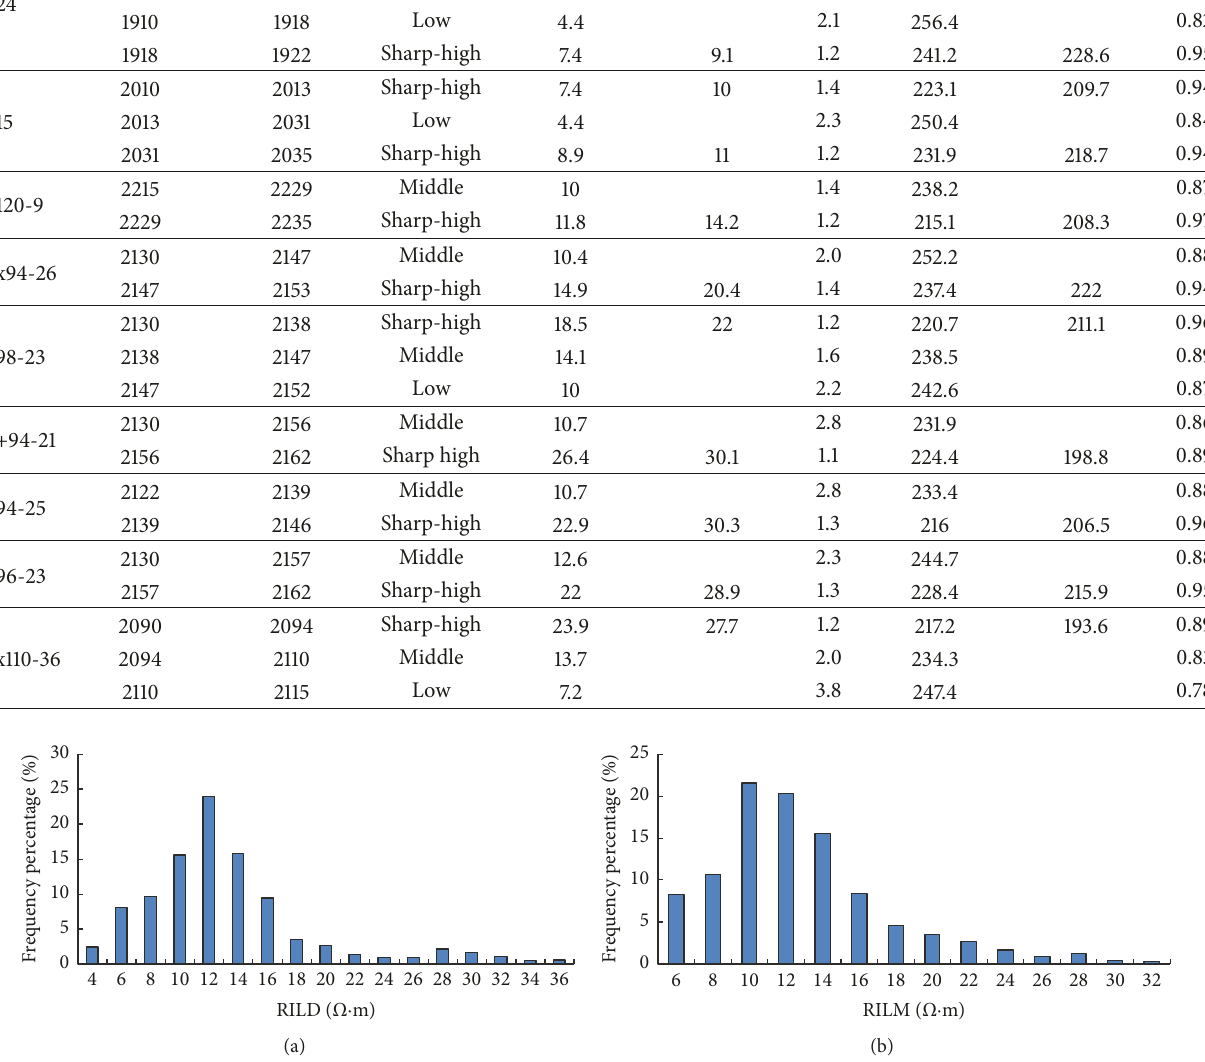
Figure 5: Histogram of the resistivity of the thick layer sand bodies in Daqingzijing. (a) RILD resistivity distribution histogram. (b) RILM resistivity distribution